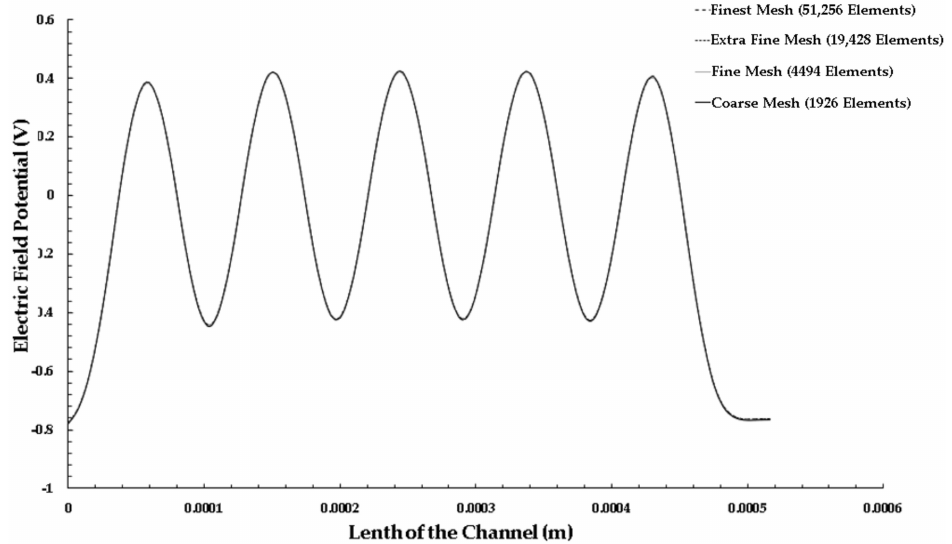
Figure 11. Plot of the velocity profile at the center of the device.